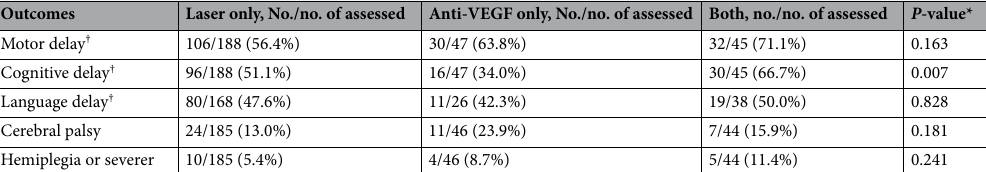
Table 4. Neurodevelopmental outcomes in infants treated for retinopathy of prematurity (ROP). *Chi-square test or Fisher’s exact test. † Motor delay is represented by a PDI score of < 85 on BSID-II or a motor score of < 85 on BSID-III or < − 1 SD on K-DST scales. Cognitive delay is represented by an MDI score of < 85 on the BSID-II subsets or a cognitive score of < 85 on the BSID-III or < − 1 SD on the K-DST scales. Language delay is defined as a language score of < 85 on the BSID-III or < − 1 SD on the K-DST scales.